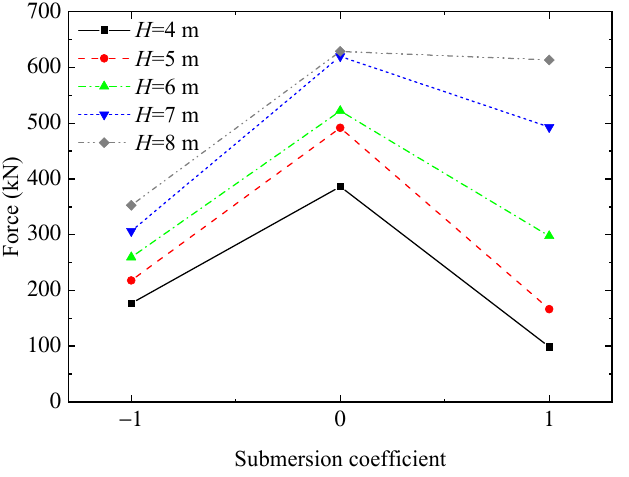
Figure 11. Comparison of the vertical peak force for Case K = 1042